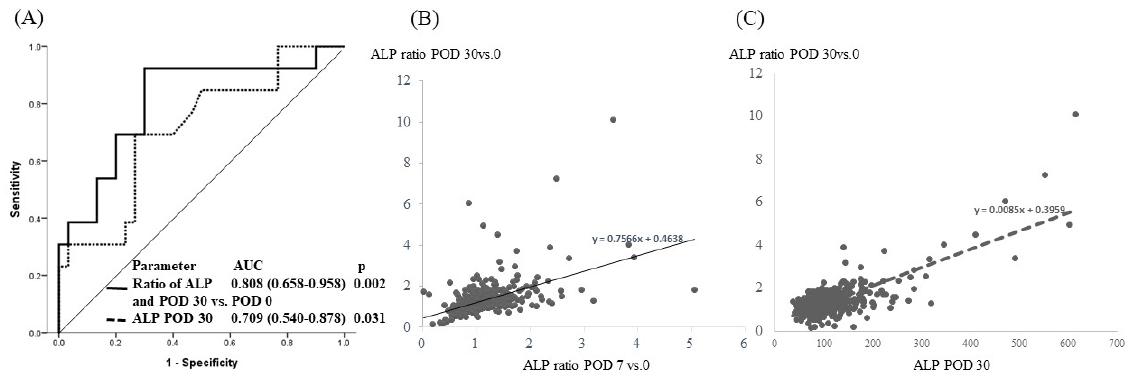
Figure 5. The perioperative ALP change and liver regeneration. ( A ) Total of 43 patients with volumetry analysis; AUROCs for liver regeneration rate >1.8 of ALP ratio (POD 30 vs. POD 0) and ALP at POD 30 were 0.808 (0.658–0.958) and 0.709 (0.540–0.878) ( p = 0.002 and 0.031, respectively). ( B ) The increase in ALP after partial hepatectomies. The ALP ratio of POD 7 vs. 0 was significantly correlated with that of ALP POD 30 vs. 0 (Pearson correlation = 0.757, p < 0.001). ( C ) The ratio of ALP at POD 30 vs. 0 was significantly correlated with that of ALP at POD 30 (Pearson correlation = 0.919, p <